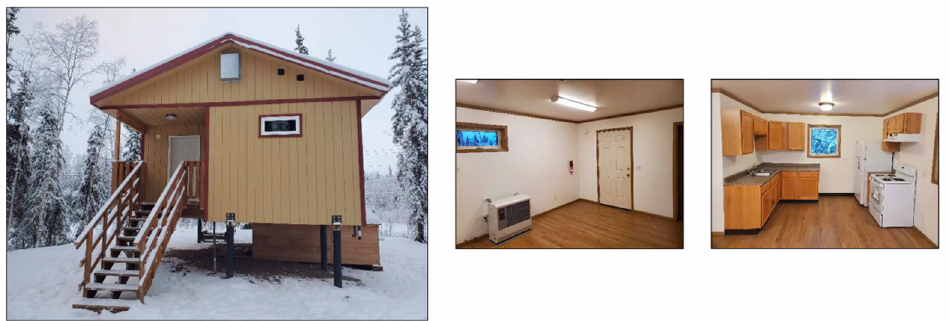
Figure 3. SEGA has expanded into construction in Galena. The image shows a recent building (with interiors) completed by interiors) completed by SEGA.